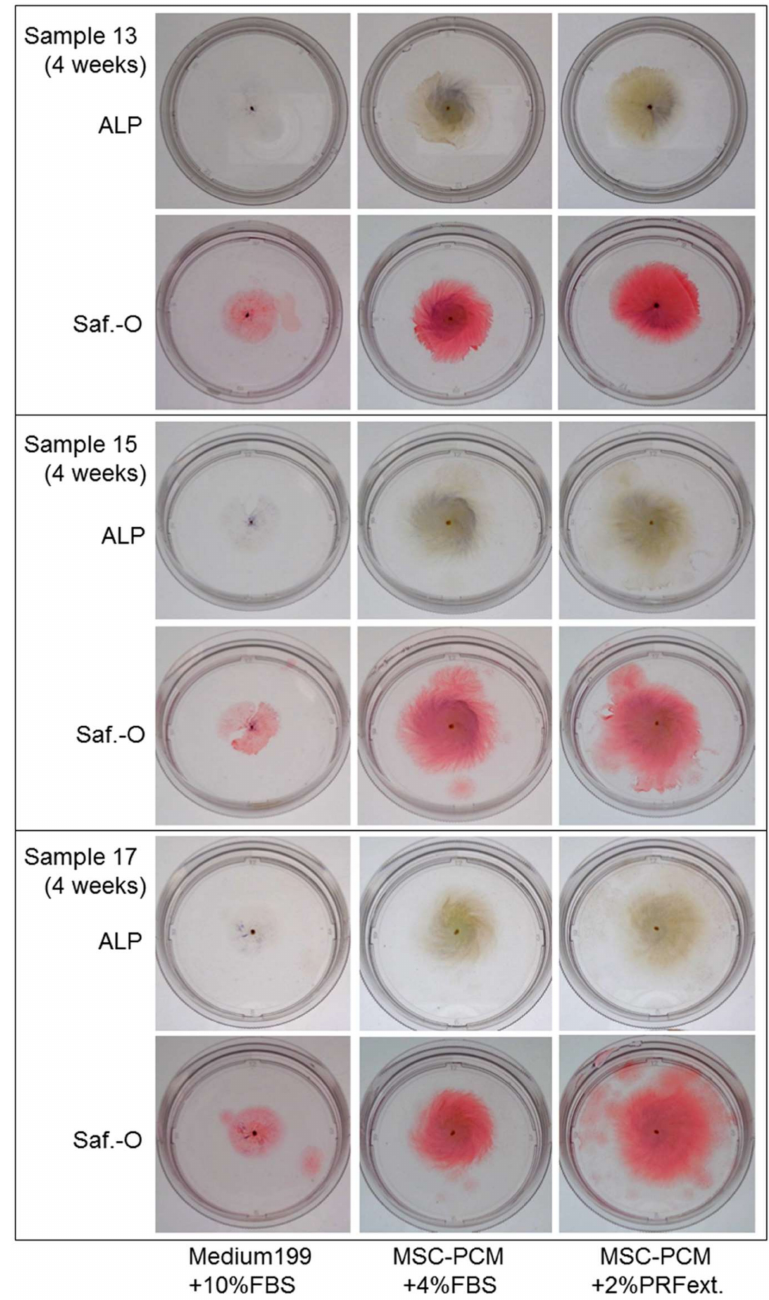
Figure 4. Effects of different culture media on the alkaline phosphatase (ALP) activity and size of periosteal sheets. Fixed individual periosteal sheets were first stained for ALP activity (positive: dark blue-purple) and subsequently treated with Safranin-O (Saf.-O) for the evaluation of their sizes. We used 60 mm culture